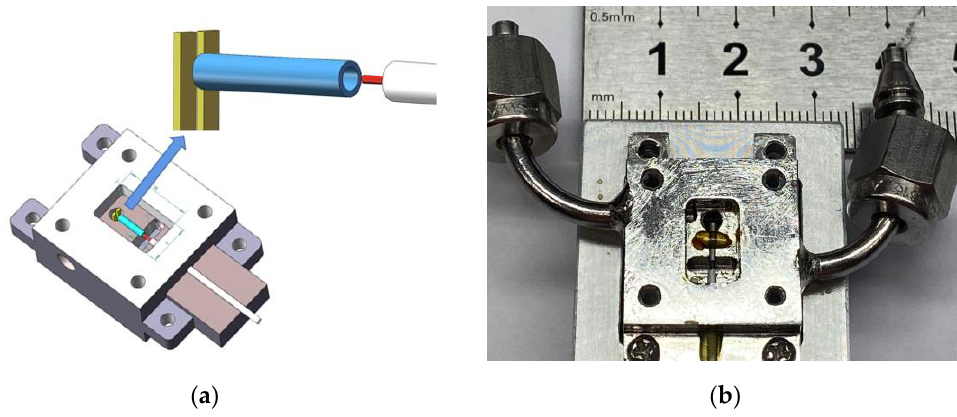
Figure 1. The schematic of the fiber-coupled spectrophone. The QTF, micro-resonator tube and fiber are fixed with epoxy resin. (a) The diagram of QEPAS cell design. (b) Photo of the spectrophone.